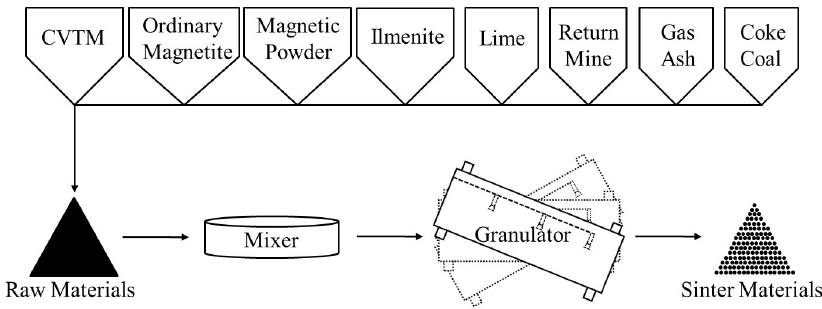
Figure 1. Granulating process of vanadium–titanium magnetite (CVTM) sinter materials.